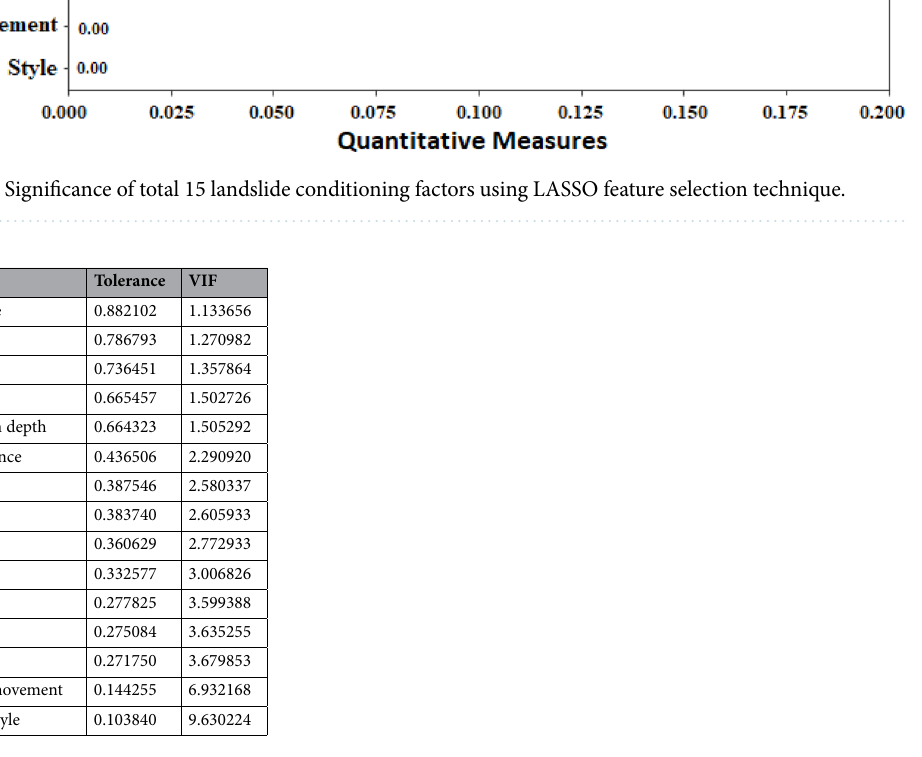
Table 3. Multicollinearity analysis using tolerance and VIF for landslide conditioning factors used in landslide prediction